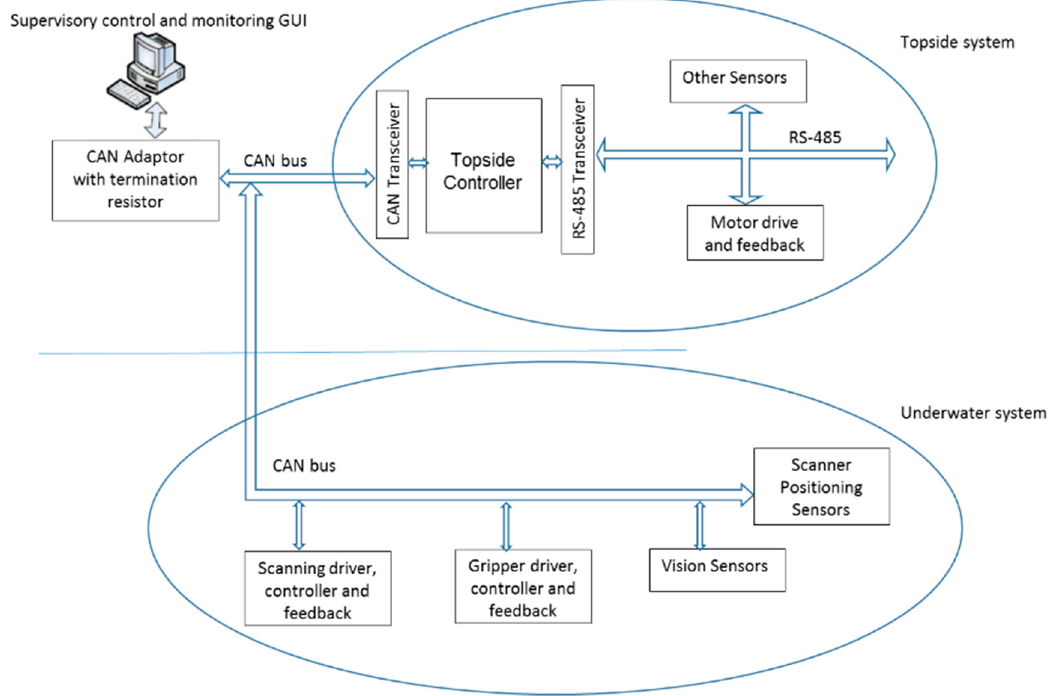
Figure 6. System Figure 6. System configuration. Figure 6. System configuration.